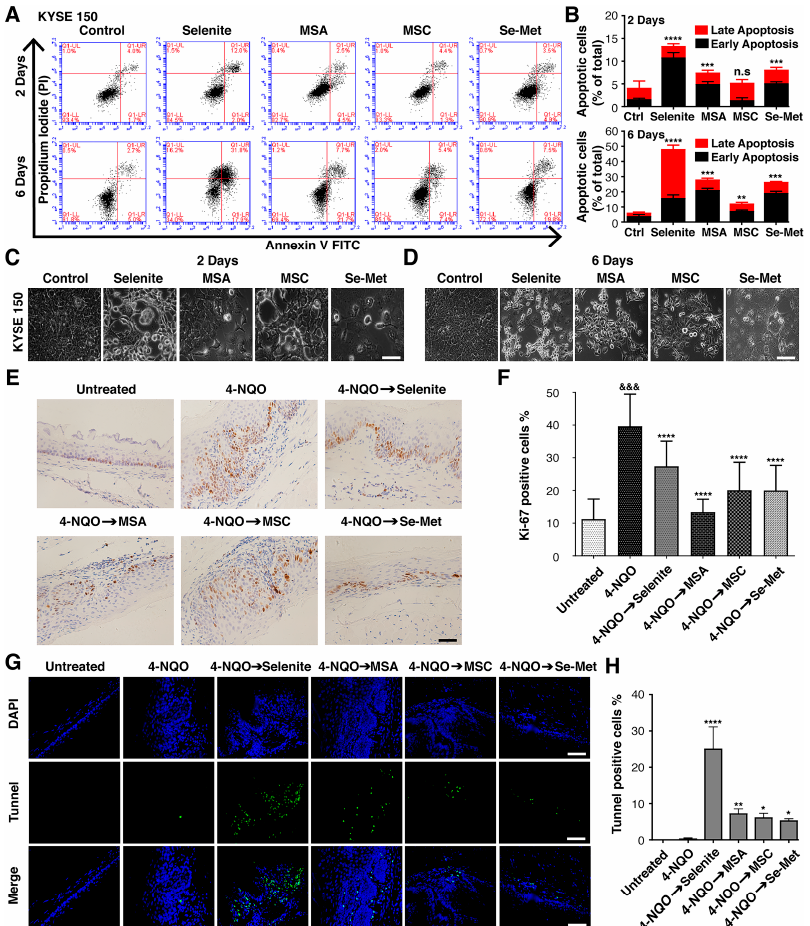
Figure 3. Effects of selenium on cell proliferation and apoptotic cell death against ESCC. Cells were treated with selenite (6 µ M), MSA (2 µ M), MSC (100 µ M), and Se-Met (100 µ M) for 2 and 6 days. Cell apoptosis was measured by flow cytometry. ( A ) Flow cytometry dot plot figures of apoptotic cells in KYSE 150. ( B ) Apoptotic cells represent the percentage of Annexin-V-single-positive and Annexin-V/PI-double-positive cells after 2 and 6 days in KYSE 150. In each dot plot figure, the upper left quadrant resembles necrotic cells; the upper right quadrant contains the later apoptotic cells, which are positive for Annexin V and propidium iodide (PI); the lower left quadrant shows viable cells, which exclude PI and Annexin V; the lower right quadrant denotes early apoptotic cells: Annexin-V-positive and PI-negative. Phase-contrast photomicrograph depicted representative morphological responses of KYSE 150 cell line at ( C ) 2 days and ( D ) 6 days. Differences are significant at (** p < 0.01, *** p < 0.001, **** p < 0.0001 vs. untreated control; n.s, non-statistically significant, n ≥ 3). Data are expressed as mean ± SD from three ( n = 3) independent experiments. Scale bar, 20 µ m. Selenium compounds, selenite (0.05 mg/kg), MSA (0.05 mg/kg), MSC (0.1 mg/kg), Se-Met (0.1 mg/kg) were administered for 4 weeks of post-completion and 16 weeks of 4-NQO exposure. The mice were sacrificed, and the esophagus sections were fixed, embedded, sectioned, and stained with anti-Ki-67 antibody and TUNNEL. Four to five representative areas of each esophagus section from each mouse were photographed and analyzed per group. ( E ) Immunohistochemical staining of Ki-67 for each treatment group. ( F ) Quantitative analysis of Ki-67-positive cells for each treatment group. ( G ) Fluorescence microscopy images of TUNEL and DAPI-stained nuclei (magnification, × 400; scale bar = 40 µ m). ( H ) Quantitative analysis of selenium-induced apoptosis for each treatment group. Differences are significant at ( &&& p < 0.001 vs. untreated group, * p < 0.05, ** p < 0.01, **** p < 0.0001 vs. 4-NQO group). The difference with p ≤ 0.05 was considered statistically